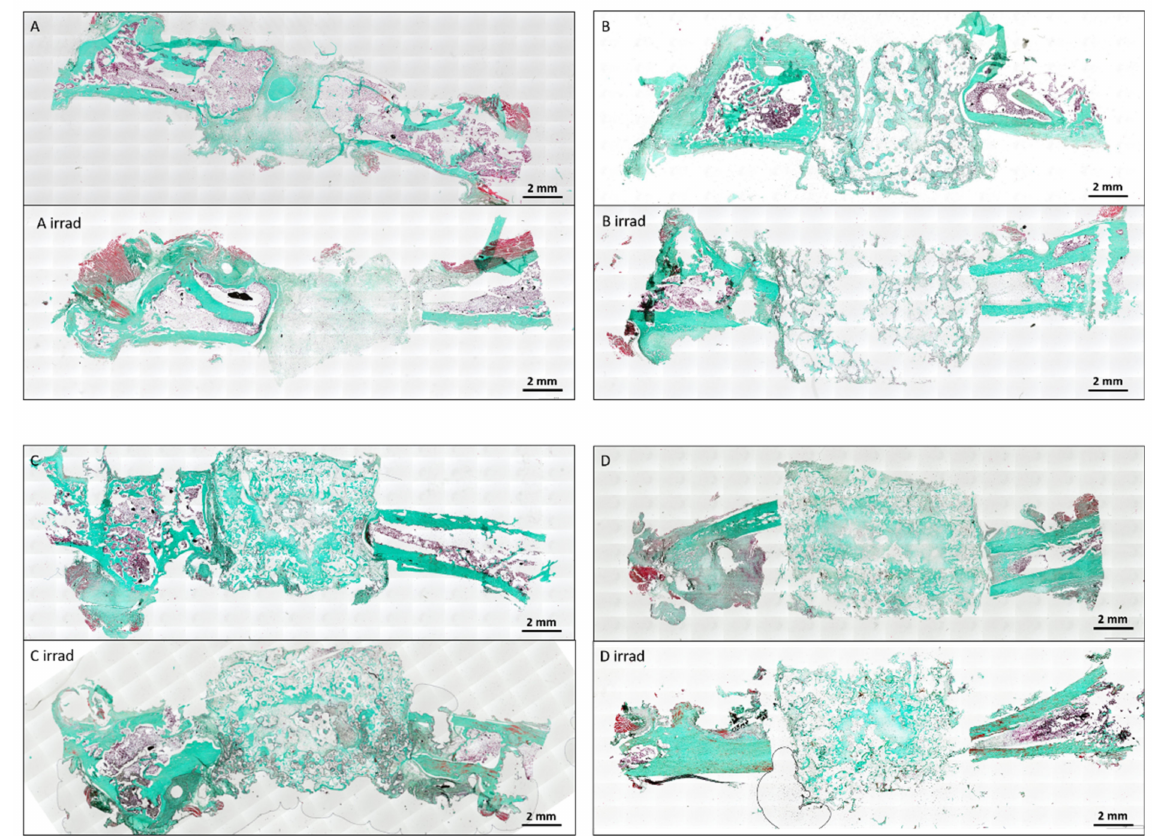
Figure 7. Masson Goldners’ trichrome staining of bone formations. The bone generation was detectable in group C/C irrad and D/D irrad, whereas no bone formation was induced by the scaffold alone (B/B irrad). Outgrowth of bone tissue from the femoral stumps was present in group A but very limited in group A irrad (black arrows). (( A – C ): 12 weeks after CSFD, ( D ): 10 days after CSFD). Scale bar 2 mm. Merged images. Total magnification ×